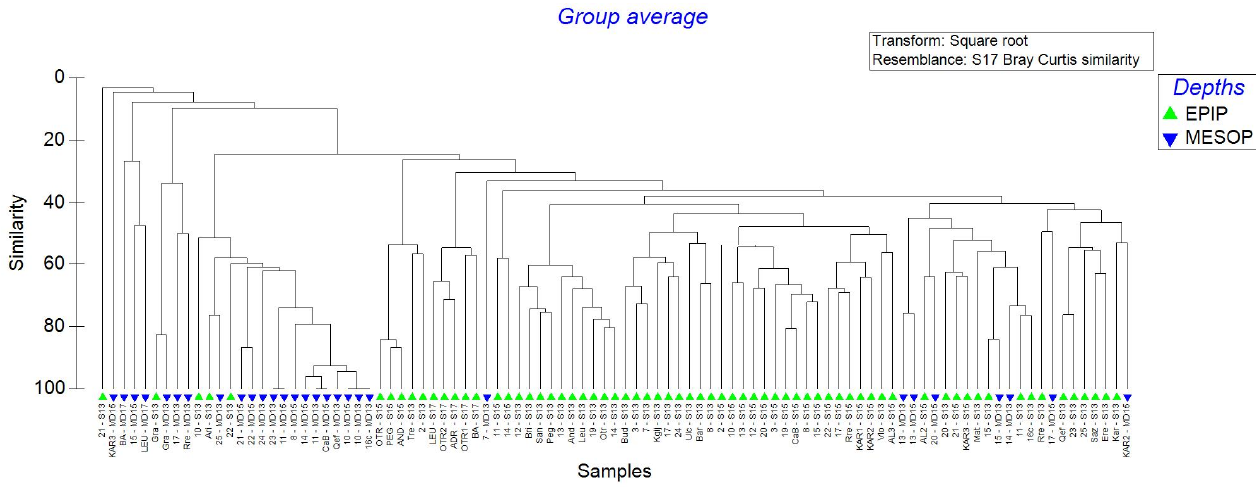
Figure 10. Representation of Hierarchical cluster analysis of samples collected in 2013, 2015 and 2017, only in Southern Adriatic Sea (Dinophyta and Ciliophora genera considered). For MD (maximum depth) samples, only those at more than 200 m below the sea level have been considered.